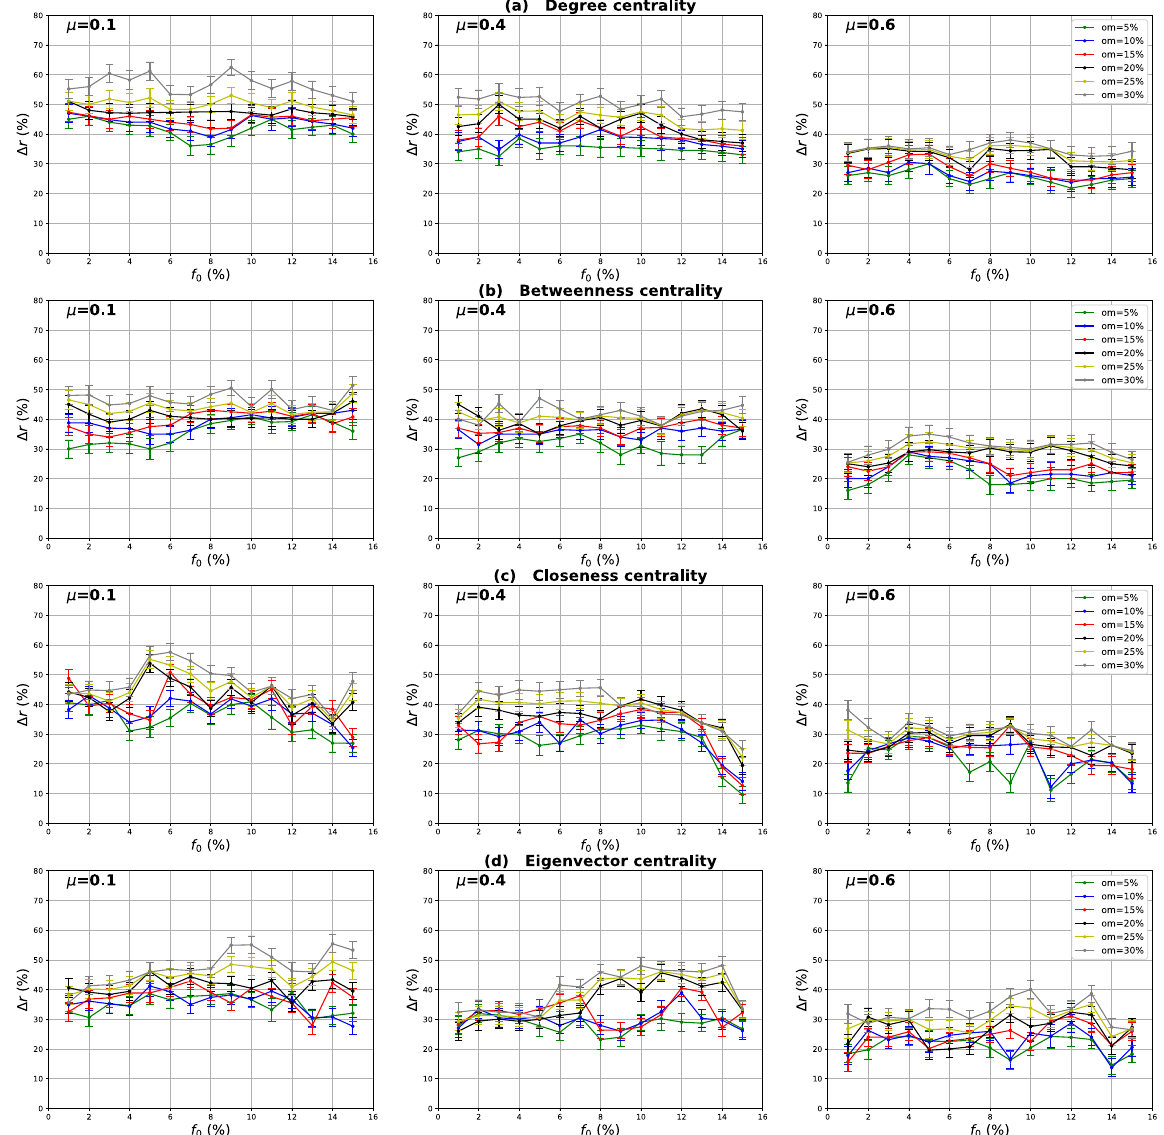
Figure 12. Influence of the community membership degree. The relative difference of the outbreak size Δ